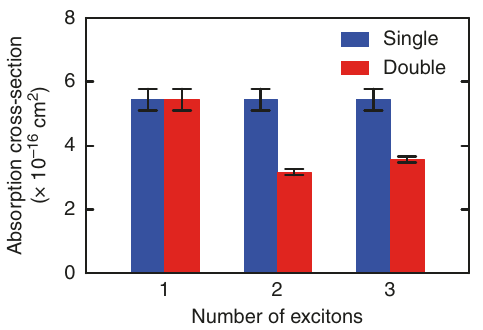
Fig. 4 Absorption cross-sections under single and double pump-pulse excitation conditions. The absorption cross-sections are shown for the single excitons, biexcitons, and triexcitons. Error bars represent the uncertainty in the determination of the absorption cross-sections Fig. 2a, b, the excitation diagrams of the single and double pump- pulse experiments are almost the same except for the absence of